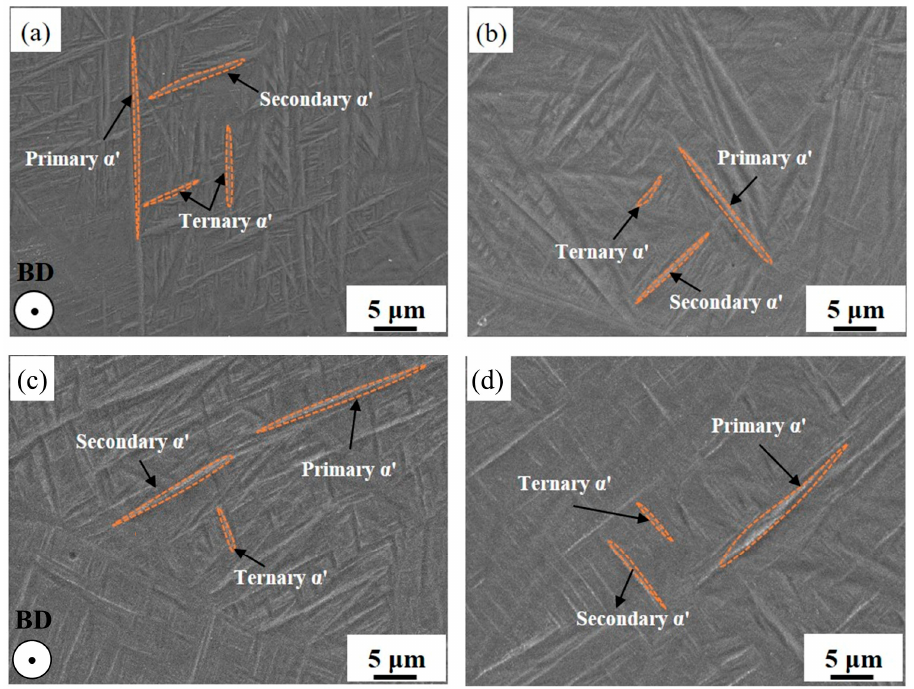
Figure 5. SEM micrographs of the LPBF-Ti64 samples before and after ECP treatment: ( a ) LPBF, ( b ) ECP-1, ( c ) ECP-2 and ( d ) ECP-3.